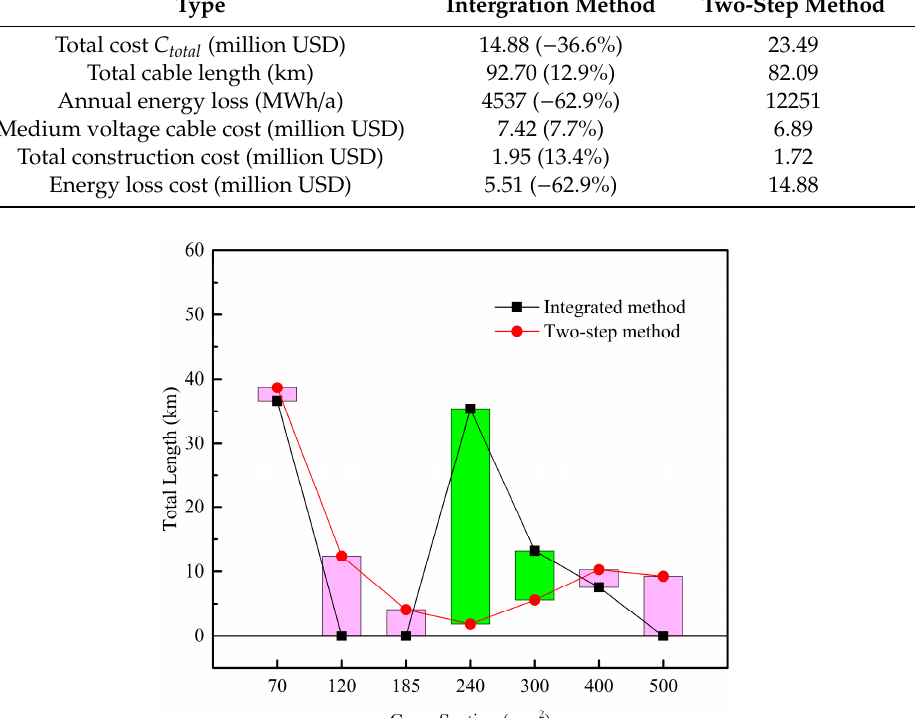
Figure 8. Comparison of the lengths of different cross-sectional cables used in the topology. Table 2. Comparison of key economic parameters of the topology (references for the % are the values obtained by the two-step method).